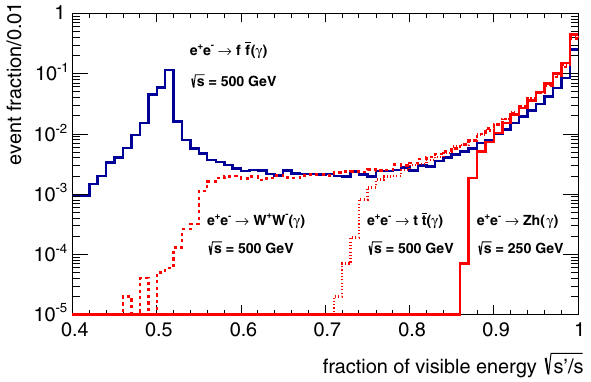
Fig. 2 Thefractionofthevisibleenergy(theenergycarriedbyallfinal- state products except the photon) in several processes, where a photon radiated off the initial- or final-state particles may accompany the final state products. The distributions correspond to pair production of light fermions in association with a photon ( e + e − → f ¯ f (γ) ), W -boson and top-quark pair production ( e + e − → W + W − (γ) , e + e − → t ¯ t (γ) ) and the Higgs-strahlung process e + e − → Zh (γ) . The centre-of-mass energy is indicated on the figure for each process